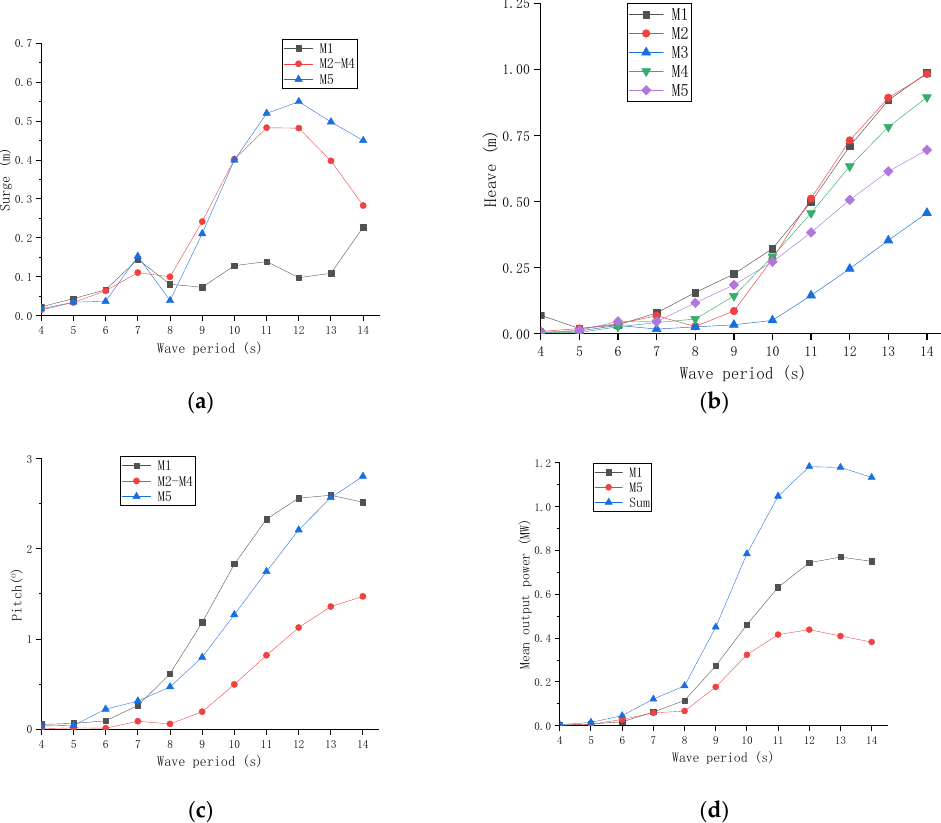
Figure 7. Main dynamic responses of the MIFS system under typical operational sea conditions: ( a ) surge; ( b ) heave; ( c ) Pitch; and ( d ) mean output power.